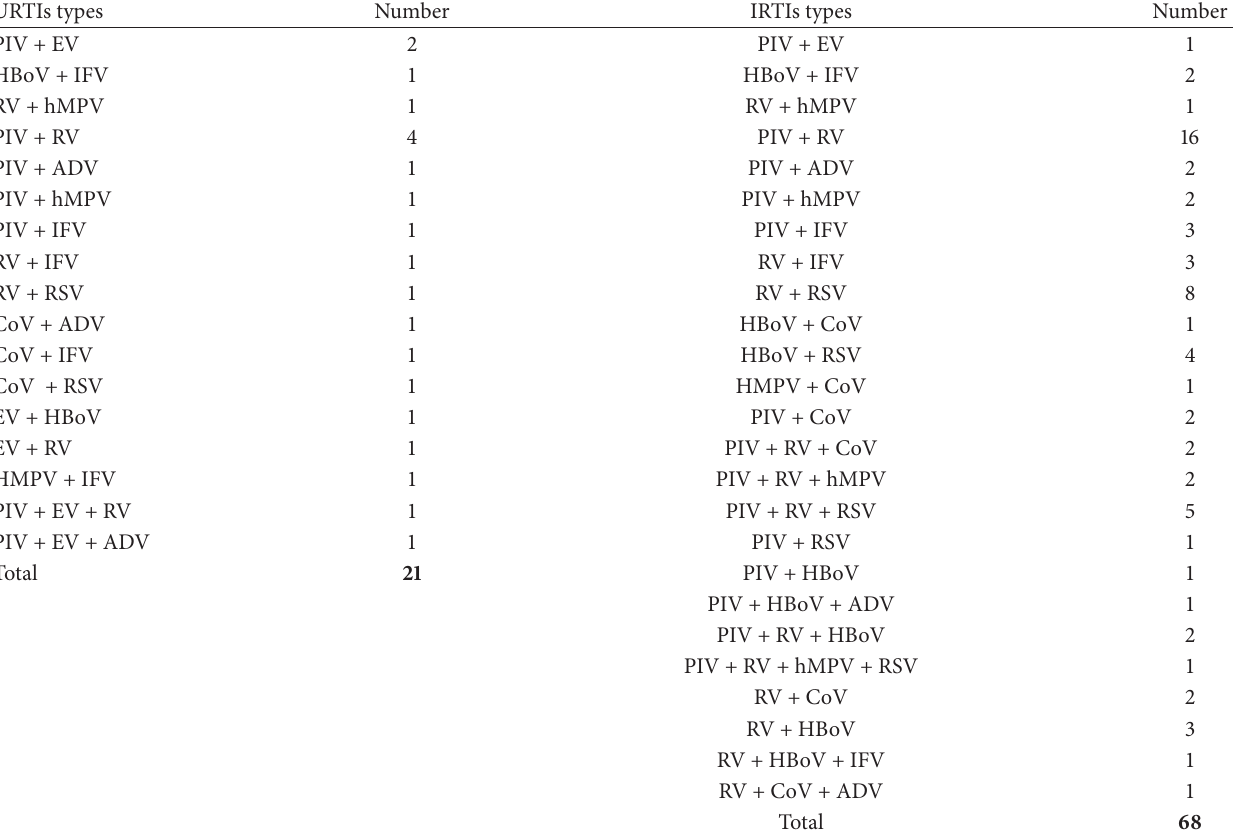
Table 3: Viral co-infection from both URTIs and LRTIs.